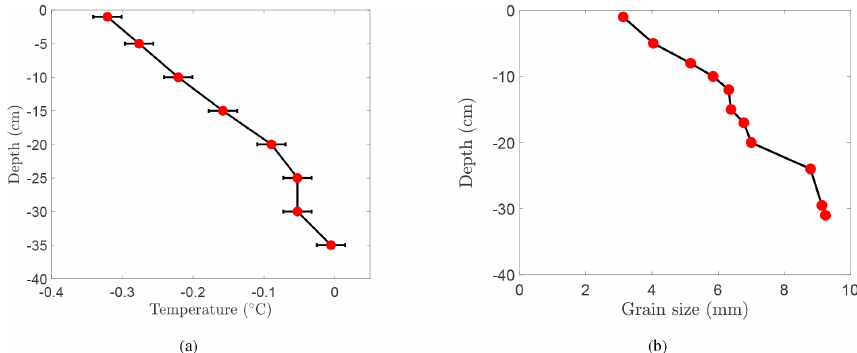
Figure 2. (a) Temperature profile. Each data point represents the average of measurements taken at the same depth of different ice cores throughout the 1-month duration of the test program. (b) Grain size distribution. Each data point is measured from one thin